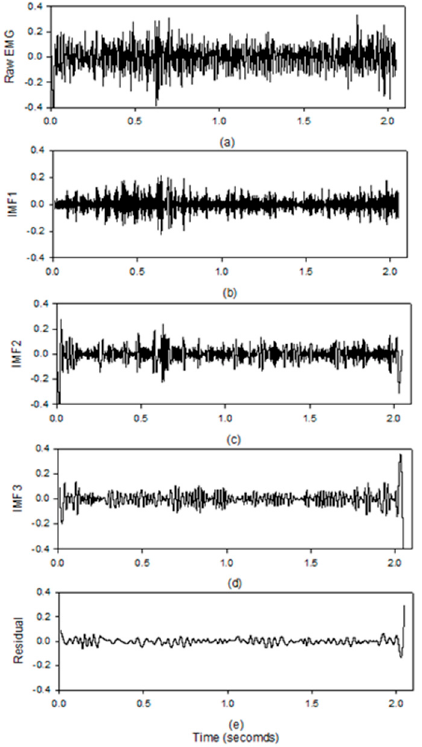
Figure 9. The IMFs of EMD for the sEMG signal decomposed using the MATLAB code in the computer